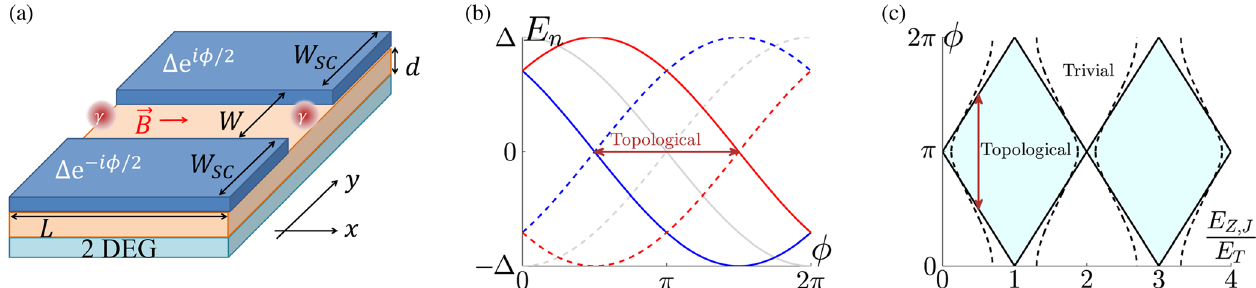
FIG. 1. (a) A Josephson junction is formed in a 2DEG with Rashba spin-orbit coupling by proximity coupling it to two s -wave superconductors with relative phase difference ϕ . An in-plane magnetic field is applied parallel to the interface between the normal and 0 . The spectrum in the absence of a Zeeman the superconducting regions. (b) The bound-state spectrum in a narrow junction for k x ¼ field is twofold degenerate and is indicated by the grey lines. In the presence of the Zeeman field, the spectrum for the two spin states (plotted in red and blue) is split, allowing for the appearance of a topological phase. (c) Phase diagram as a function of the Zeeman field π = 2 Þ v =W and the phase difference ϕ . The solid lines are the phase in the junction, E , given in units of the Thouless energy E Z;J T ¼ ð F boundaries in the absence of any normal backscattering at the superconducting-normal interface, while the dashed lines correspond to a 3 π = 8 as defined in Sec. III A. The arrows indicate the range of ϕ values between W þ φ junction transparency of 0.75 and a phase k F N ¼ the two zero energy crossings in (b) for which the system is